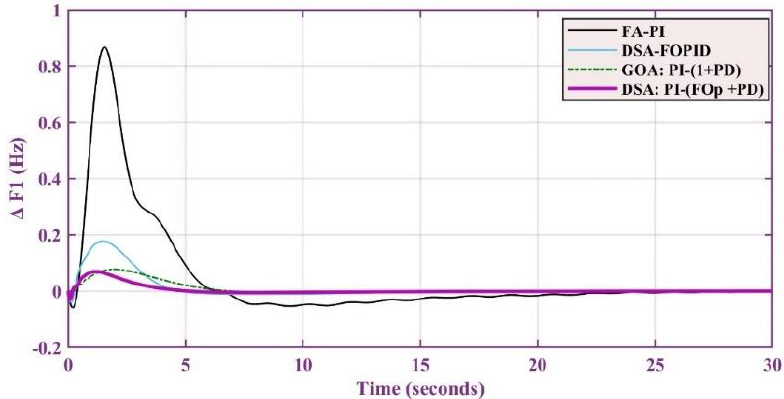
Figure 6. Response at 1% load change for area-1 .